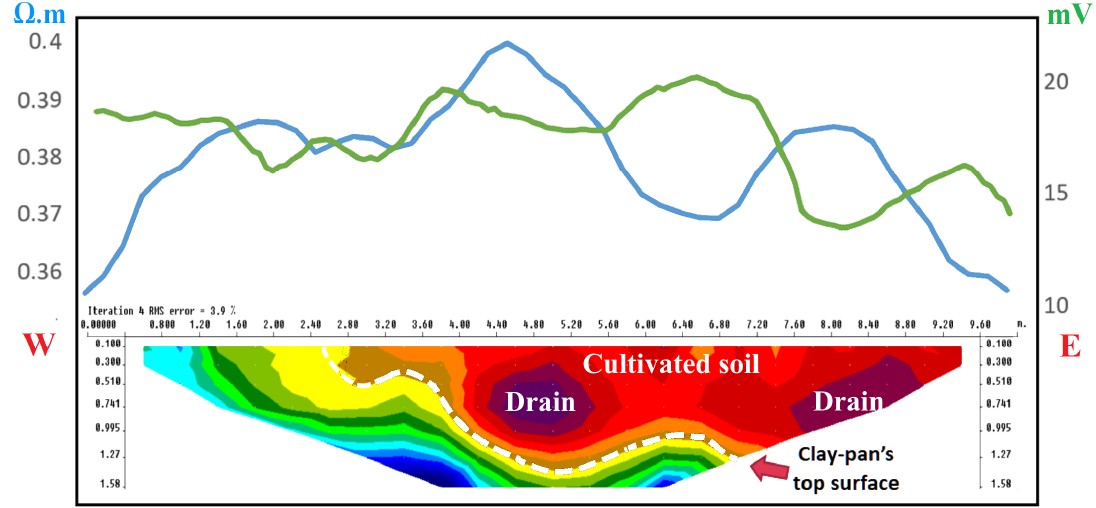
Figure 8. Spontaneous potential curve (green), apparent resistivity gradient curve (light blue), and the ERT model of the same profile surveyed at Farm A.